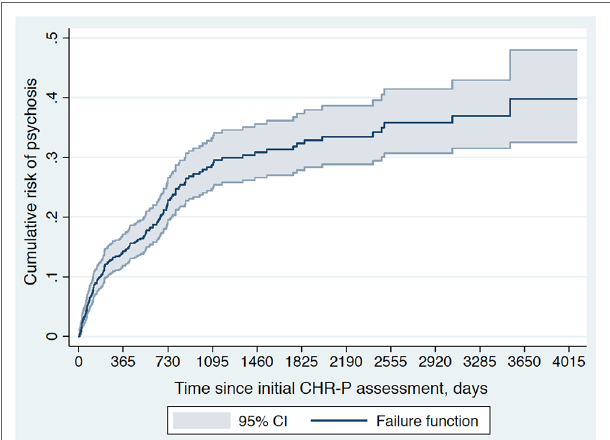
FIGURE 3 | Cumulative risk of psychosis onset (failure function) in 787 CHR-P individuals from the Pan-London Network for Psychosis-Prevention (PNP). There were 503 individuals at-risk at year 1, 283 individuals at-risk at year 2, 192 individuals at-risk at year 3, 158 individuals at-risk at year 4, 139 individuals at-risk at year 5, 113 individuals at-risk at year 6, 110 individuals at-risk at year 7, 72 individuals at-risk at year 8, 42 individuals at-risk at year 9, and 29 individuals at-risk at year 10. The function was truncated at 4081 days of follow-up when 10 individuals were still at-risk for